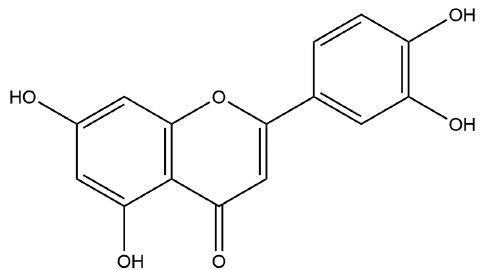
Figure 1. Chemical structure of luteolin.